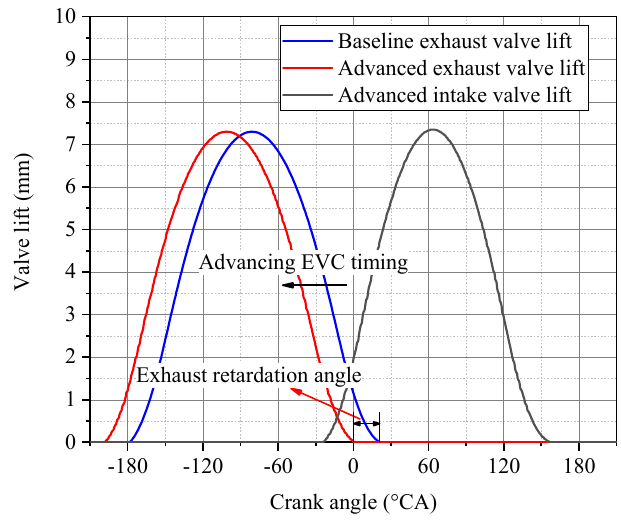
Figure 3. Method of analyzing the influence of exhaust retardation angle on the engine characteristics under the Miller cycle (by advancing EVC (Exhaust Valve closing) timing).